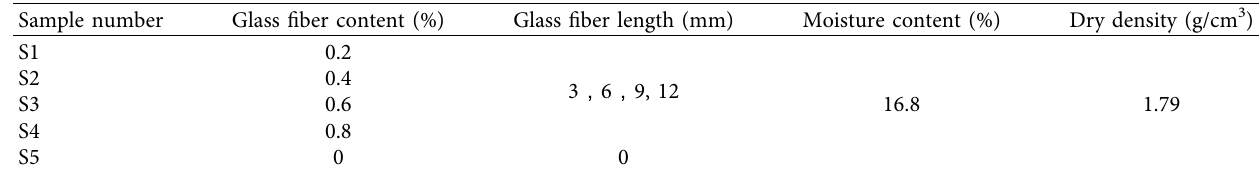
Table 3: Test protocol table.